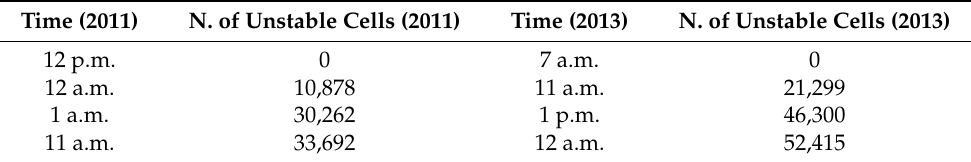
Figure 9. Slope stability conditions, expressed in terms of safety factor (FS), during the 2011 event according to the TRIGRS model. Table 3. Number of unstable cells predicted by TRIGRS at different times during the 2011 and 2013